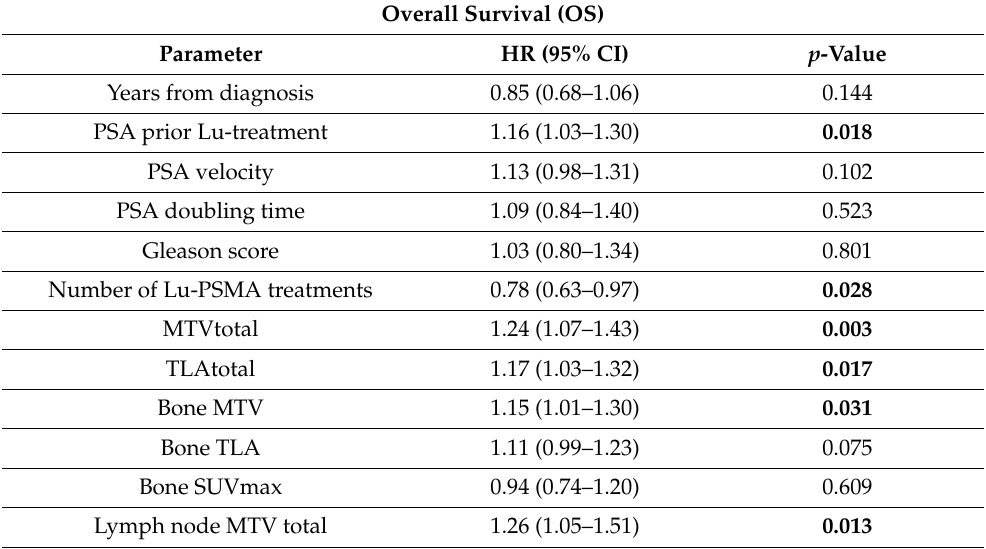
1.03–1.55, p = 0.02). Table 3. Possible predictors for overall survival (OS). MTV = Metastatic tumor volume, TLA = Total lesion activity (meanSUV*tumor volume).